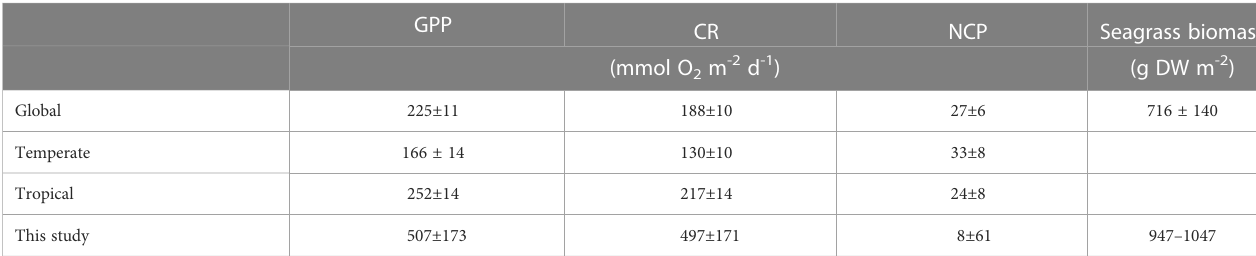
TABLE 1 Comparison of gross primary production (GPP), community respiration (CR), net community production (NCP), and seagrass biomass in dry weight units of Dongsha Island (this study) with those for global, temperate, and tropical seagrass meadows as studied by Duarte et al. (2010) for GPP,CR and NCP, and Fourqurean et al. (2012) for total